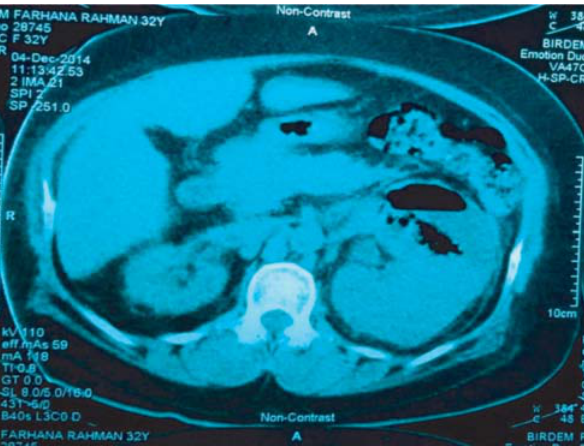
Fig 3B. CT scan of abdomen showing gas in left renal pelvis and parenchyma